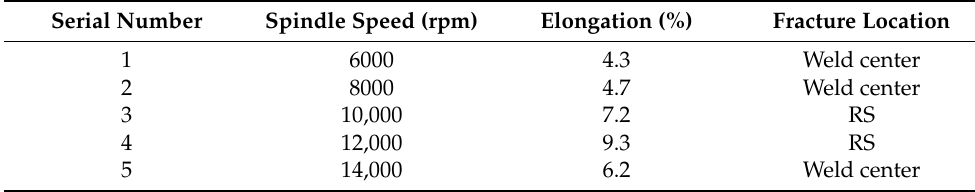
Table 3. Fracture position of joint at different